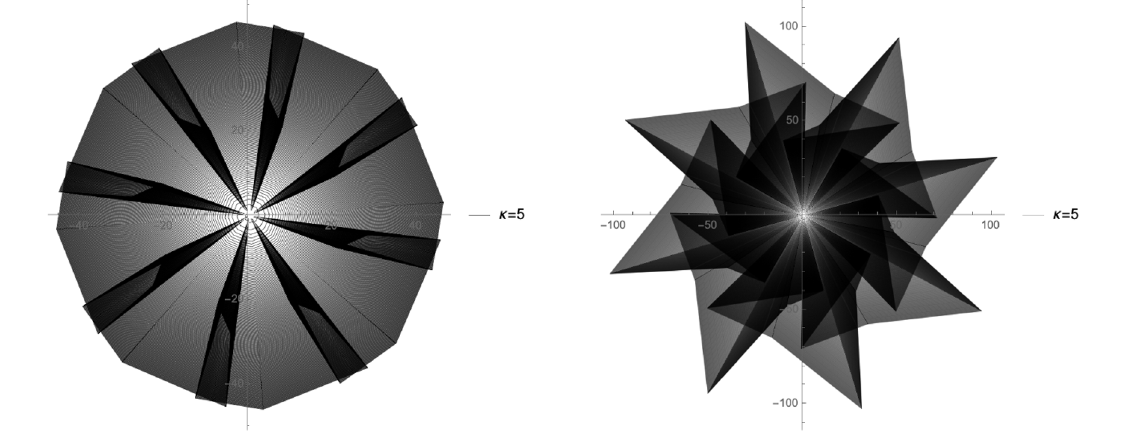
p 0 : 03 + i 0 : 1 and % = 1 ; : : : ; 10 4 .